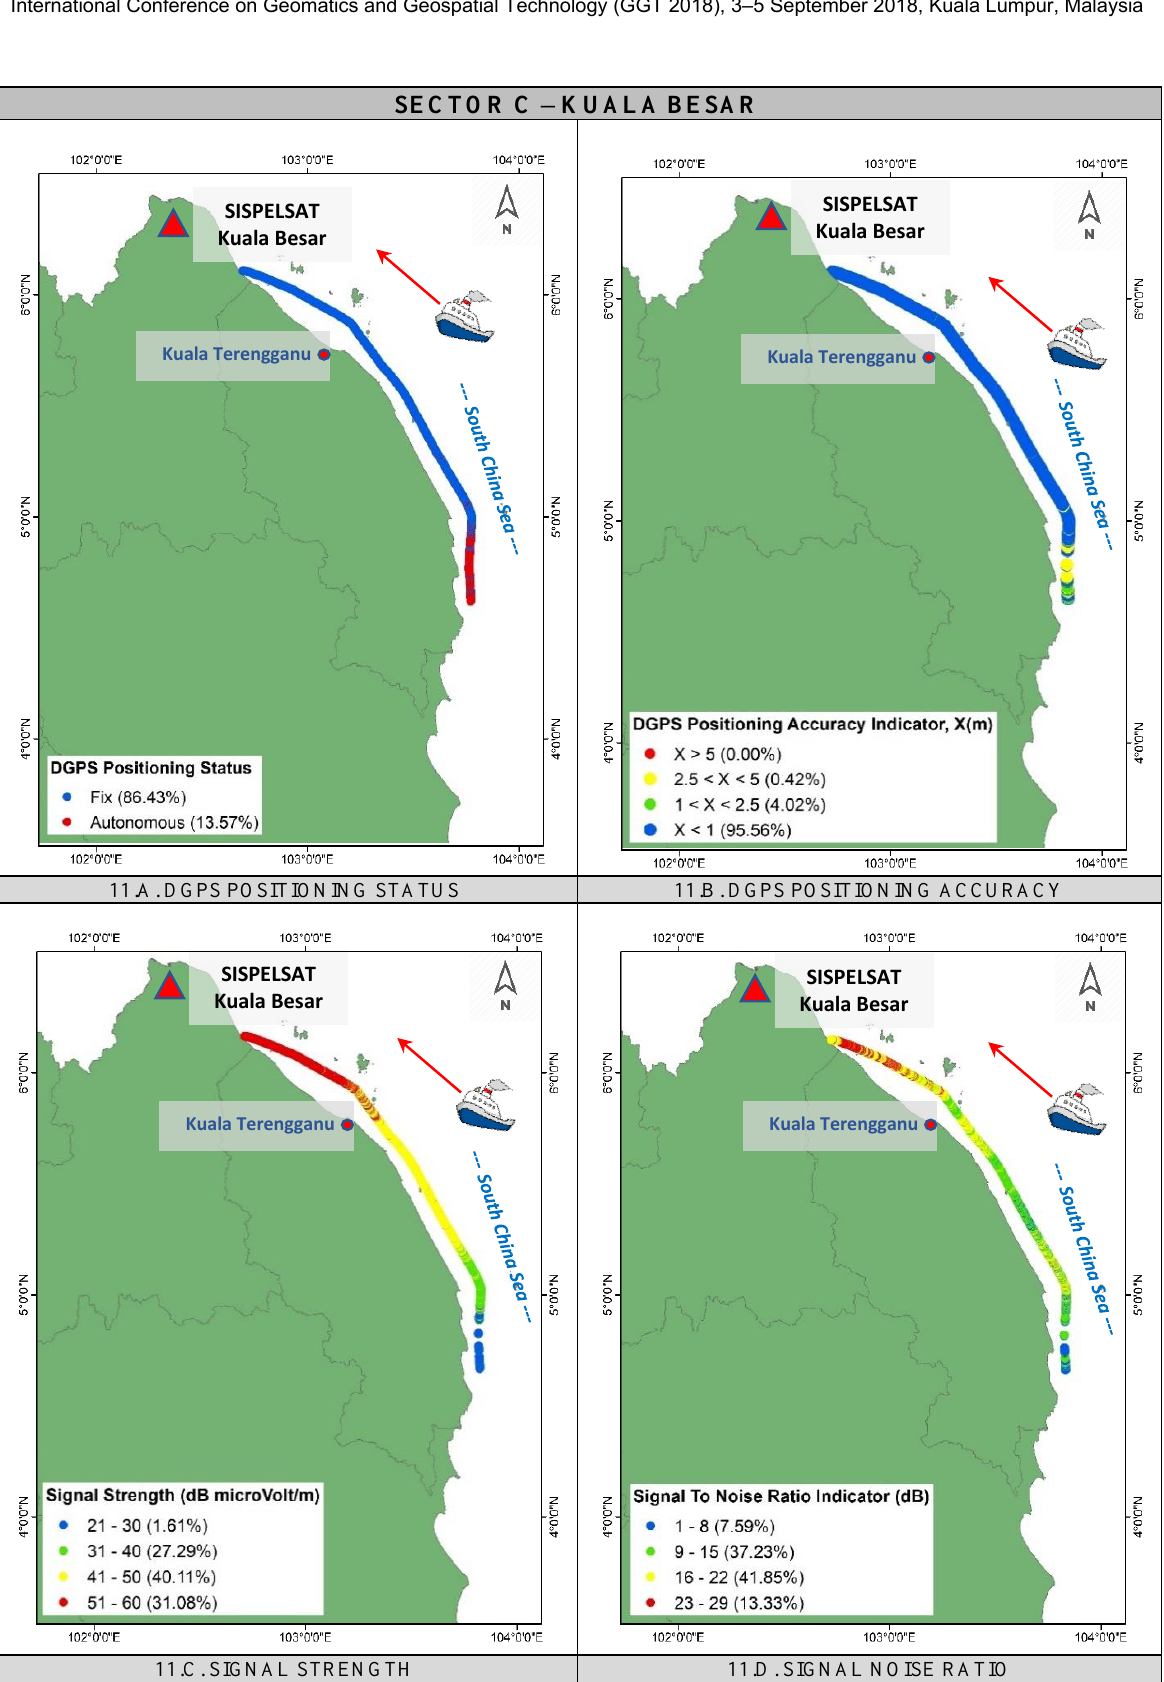
Figure 11. Result map of sector C– SISPELSAT Kuala Besar